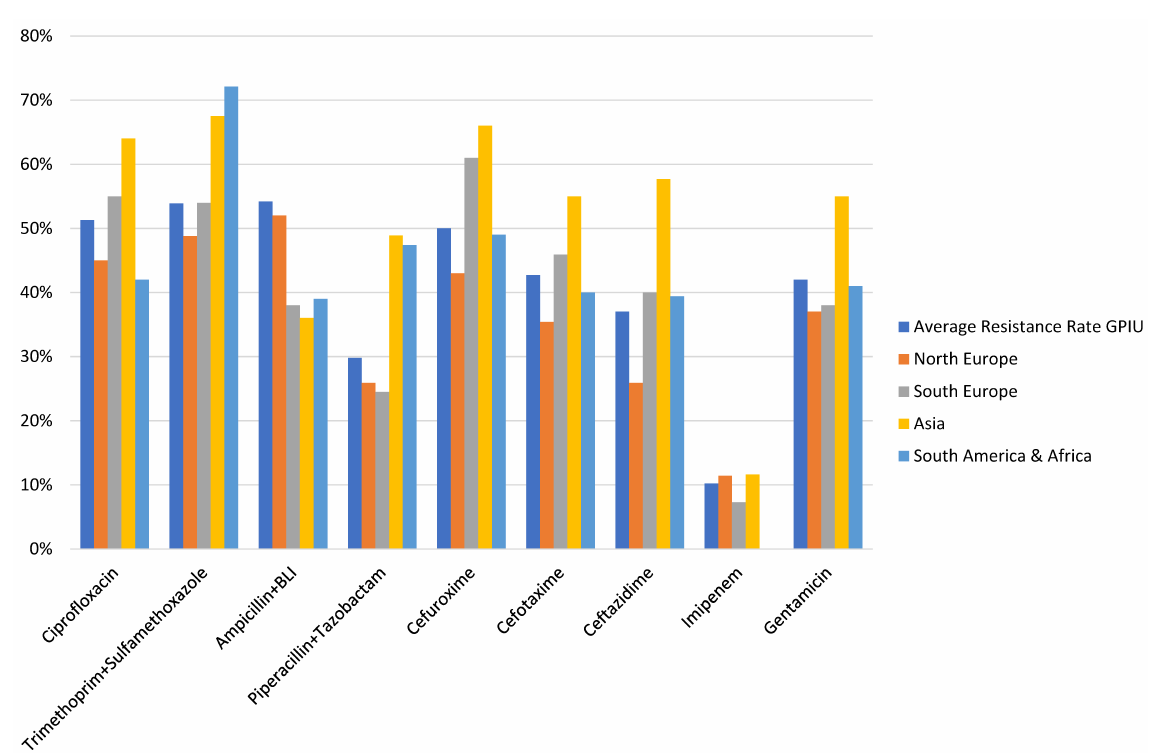
Figure 4: Resistance patterns to antibiotics in patients with HAUTIs from the GPIU study 2003–2013 [29];